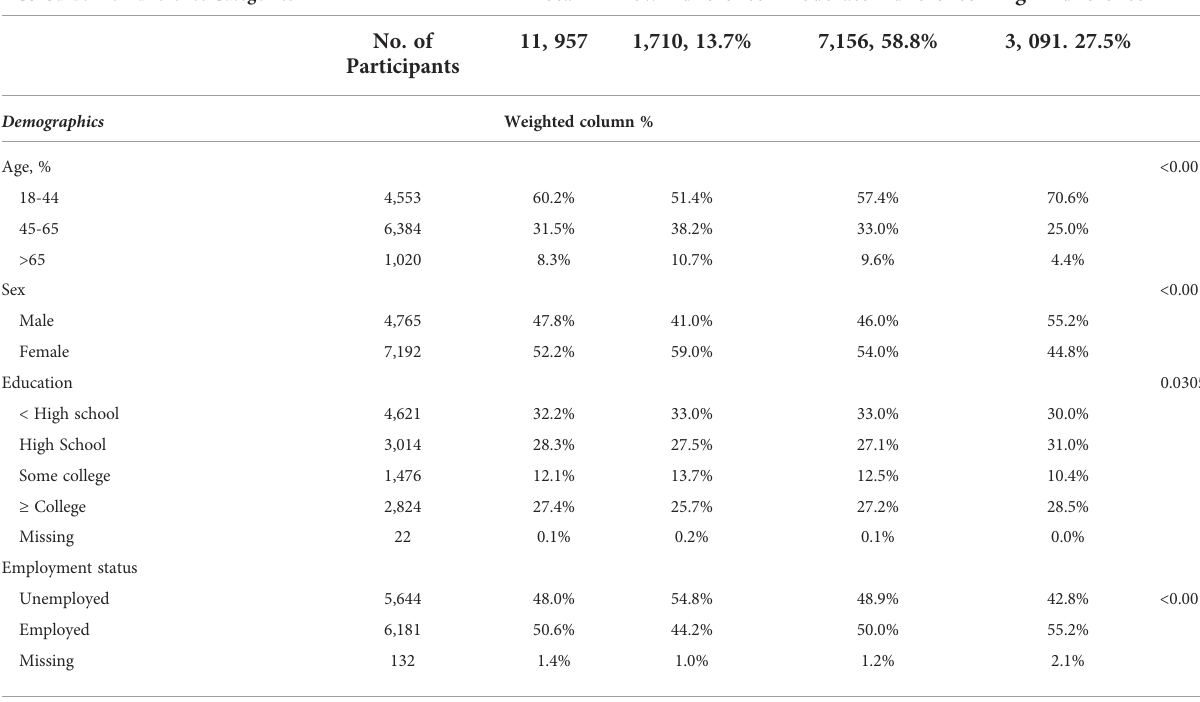
TABLE 2 Characteristics of U.S. Hispanic/Latinos by ACS guidelines on nutrition and physical activity for cancer prevention